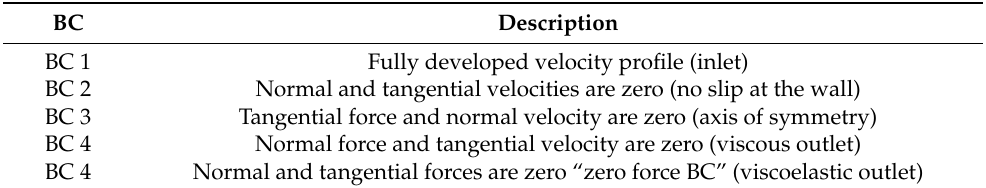
Table 1. Boundary conditions (BCs) applied in CFD